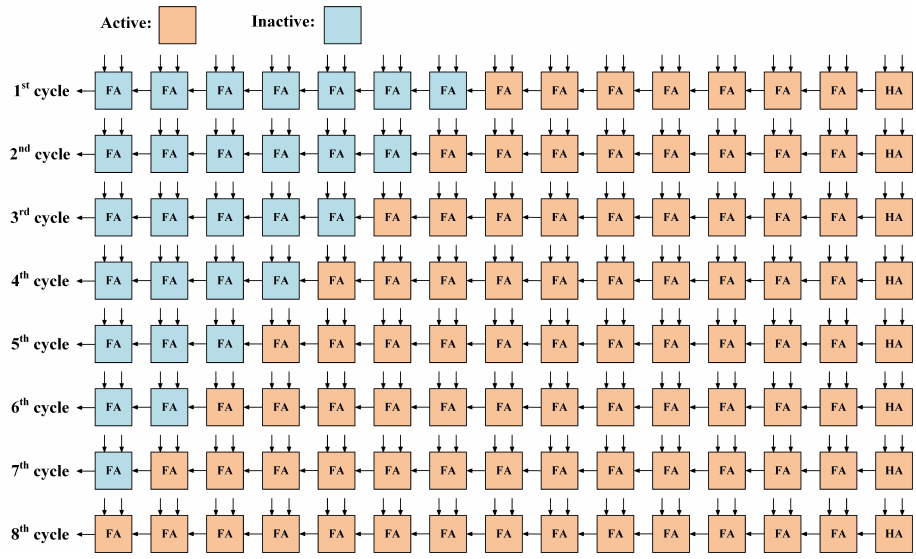
Figure 3. The state change of full adder in the accumulator circuit for an 8-bit distributed arithmetic (DA) computation.